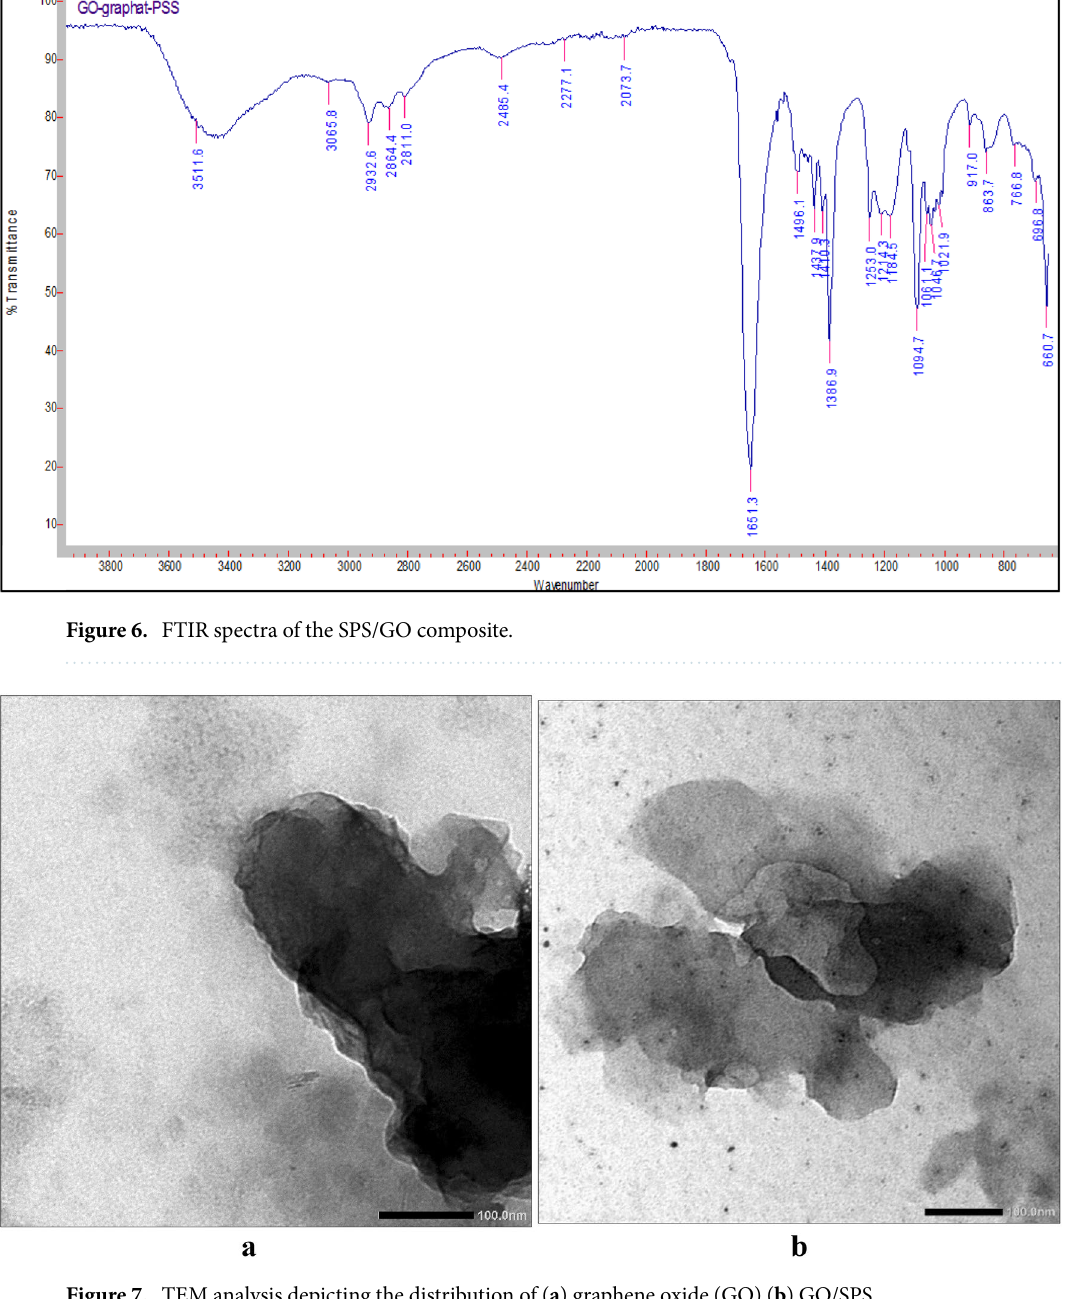
Figure 7. TEM analysis depicting the distribution of ( a ) graphene oxide (GO) ( b )